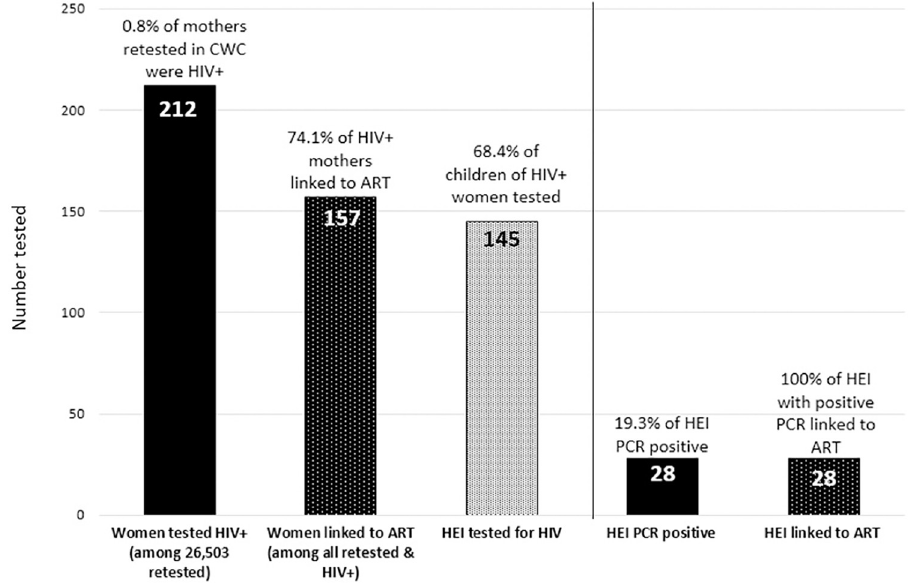
Fig 3. Maternal and HIV-exposed infant testing in child welfare clinics, Mozambique July-November 2019.